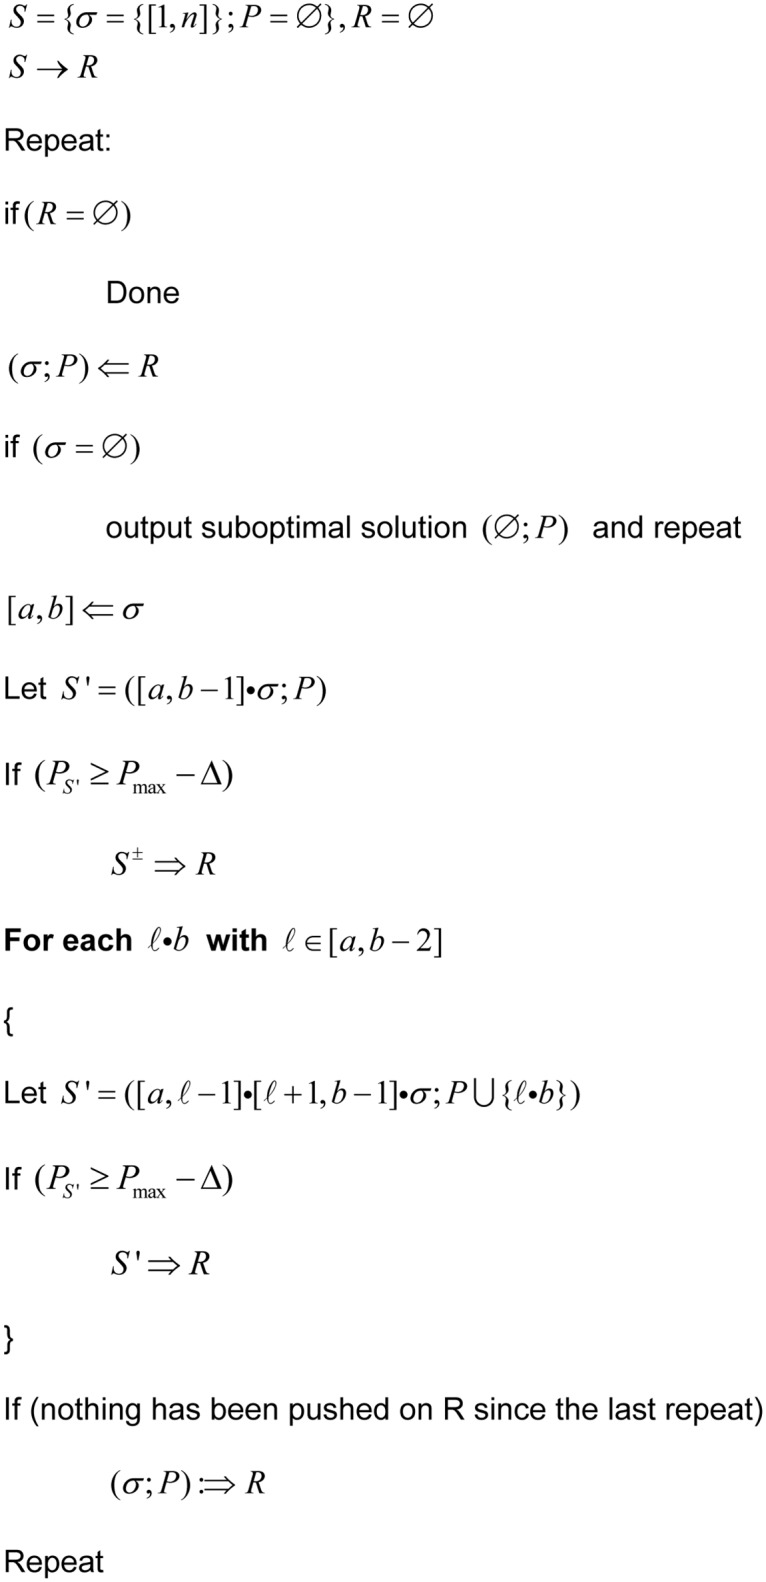
Pseudocode for the generation of suboptimal structures with the Wuchty algorithm.The pseudocode for the Wuchty algorithm is reproduced from the original description of the algorithm in reference [15]. P is a set of pairs i, j. S is a partial structure. σ is a stack. ∅ is an empty stack. R is a stack of partial structures. ℓ is the length of the sequence. Bold text highlights where new constraints were applied to the evaluation of a base pair.